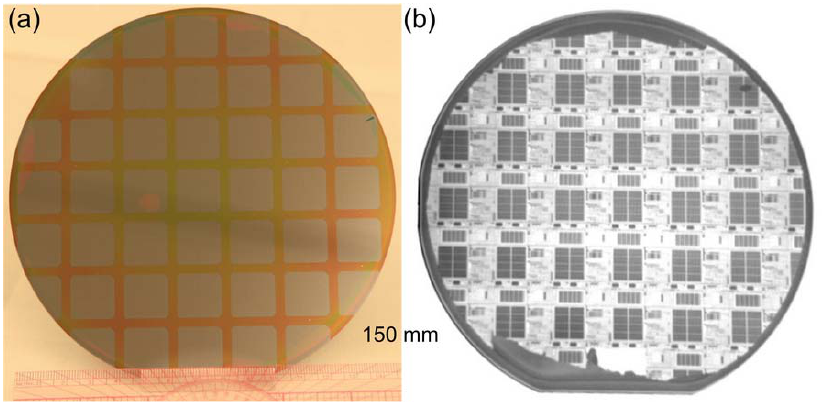
Figure 4. (a) Photograph of processed 150 mm diameter O showing individual device dies. (b) IR image of 150 mm SiO CMOS devices successfully